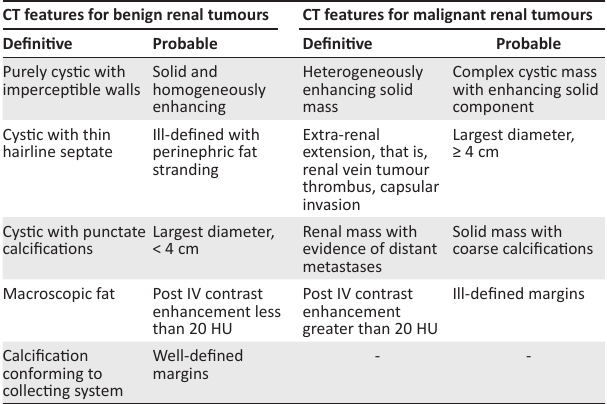
TABLE 1: Criteria for differentiating benign and malignant renal tumours on computed tomography scan. CT features for benign renal